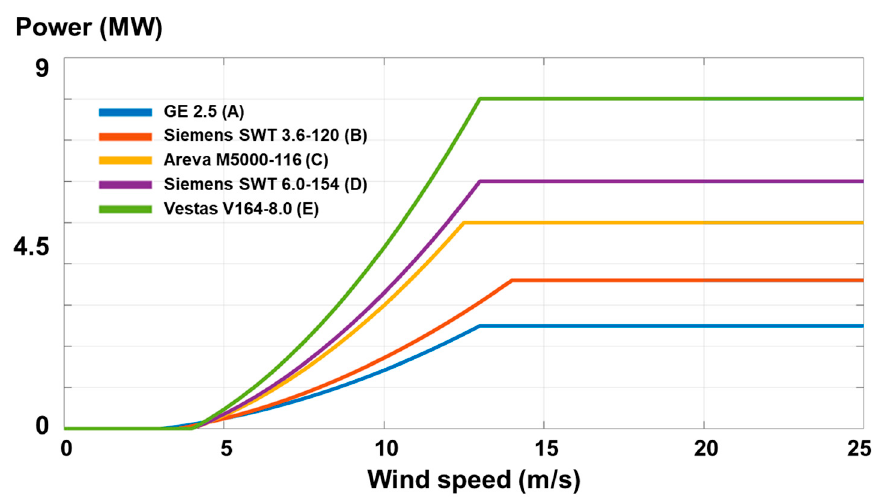
Figure 5. Power curves of the turbines considered for evaluation.